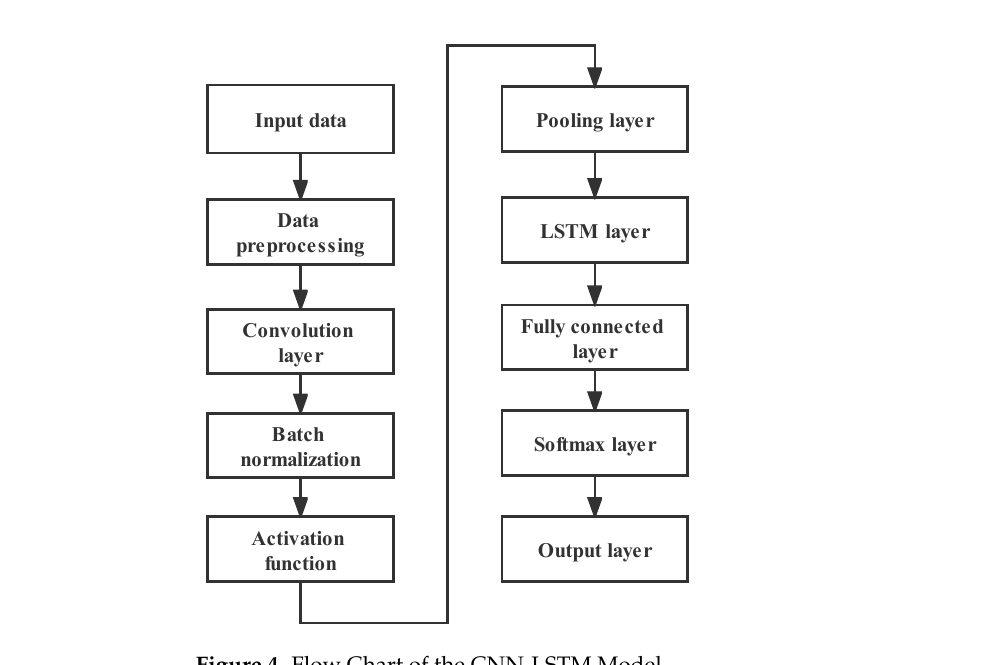
Figure 4. Flow Chart of the CNN-LSTM Model.